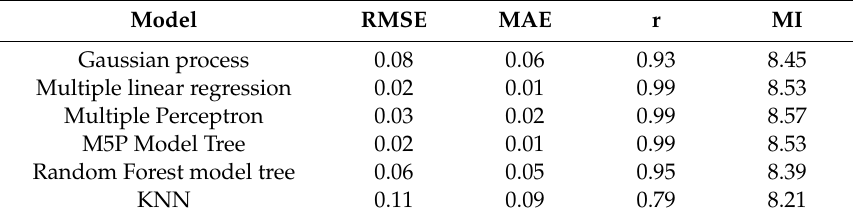
Table 9. Summary of performance of multiple ML models with training data from 2005 to 2012.